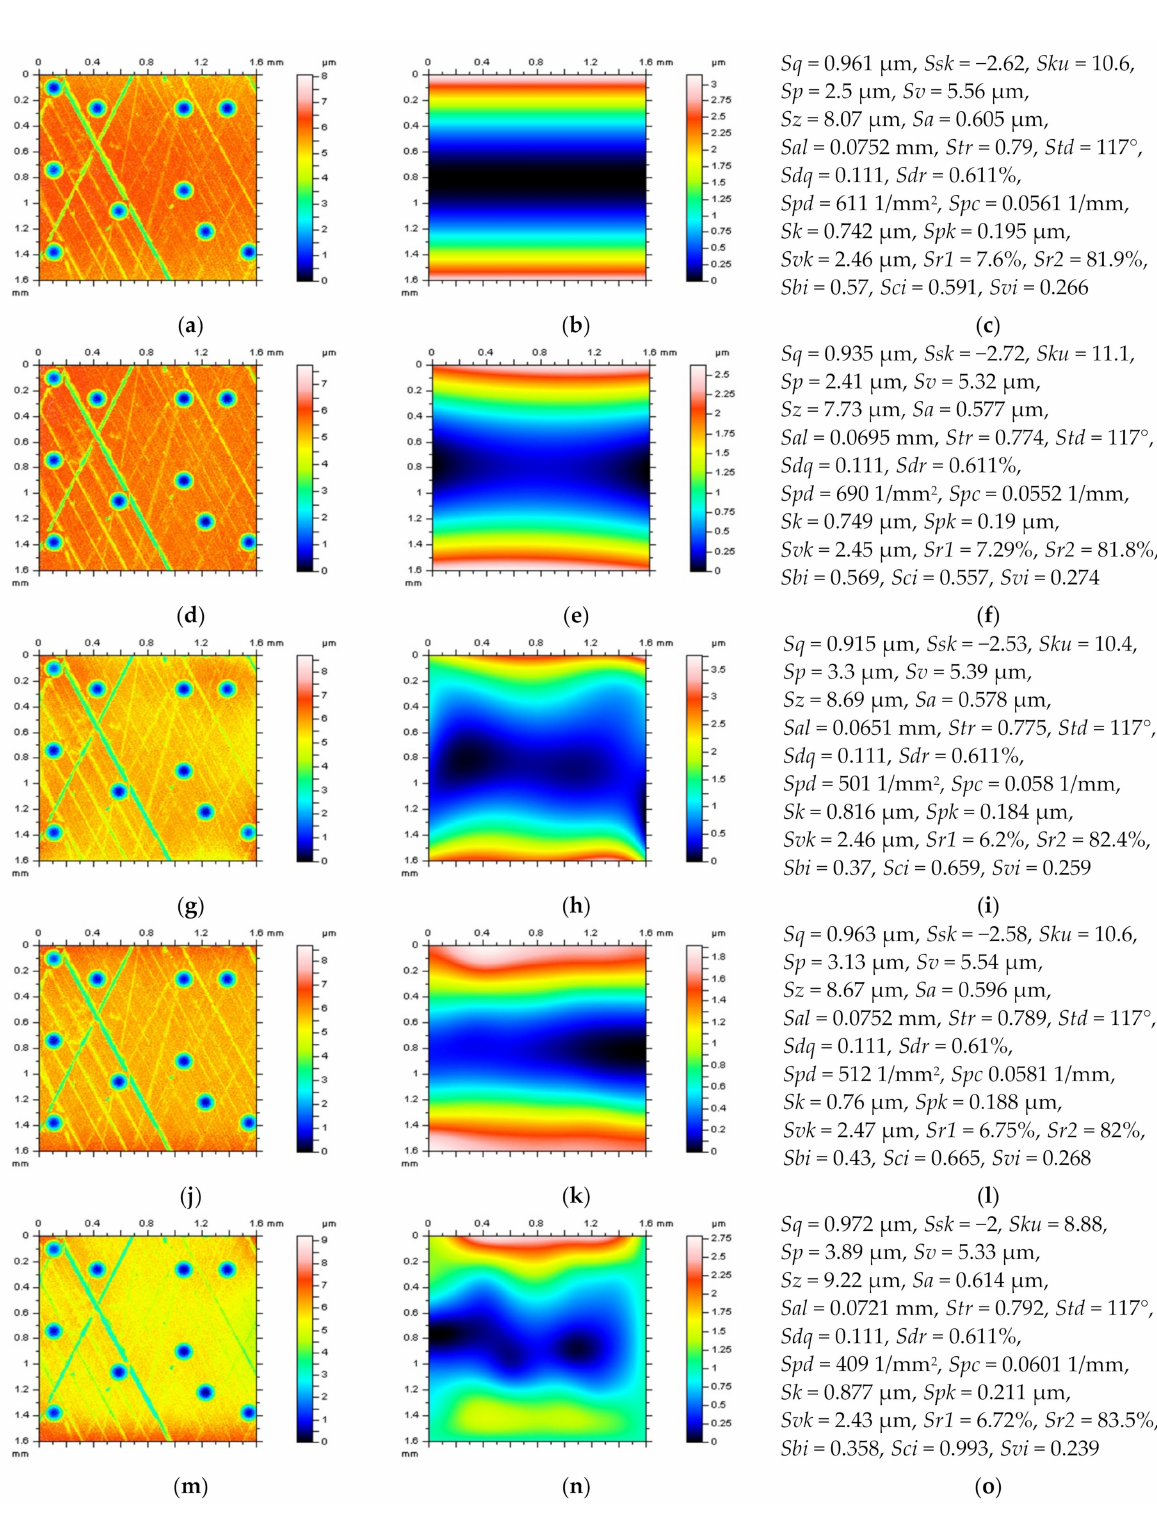
Figure 2. Contour map plots of the surface after the areal form removal (left column), reference planes (middle), and ISO 25178 parameters (right column), received from a plateau-honed cylinder liner surface with oil pockets created by burnishing techniques, after the application of LSFC ( a – c ), POLY2 ( d – f ), POLY6 ( g – i ), RGRF ( j – l ), and SF ( m – o ), cutoff = 0.8